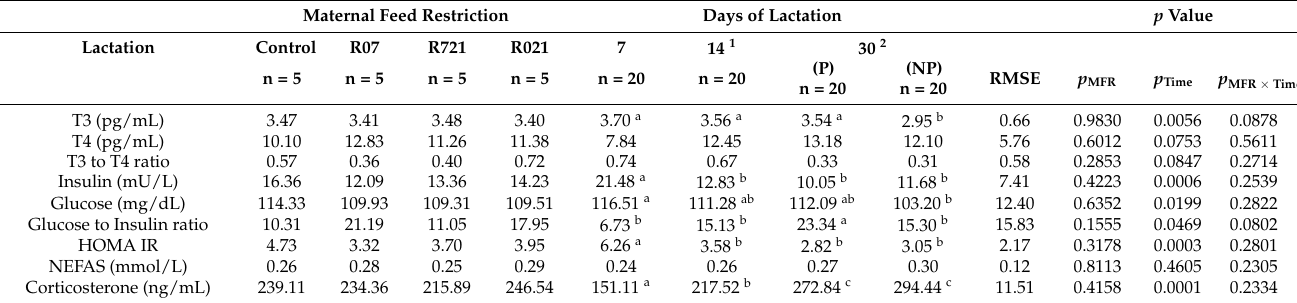
different letters are significantly